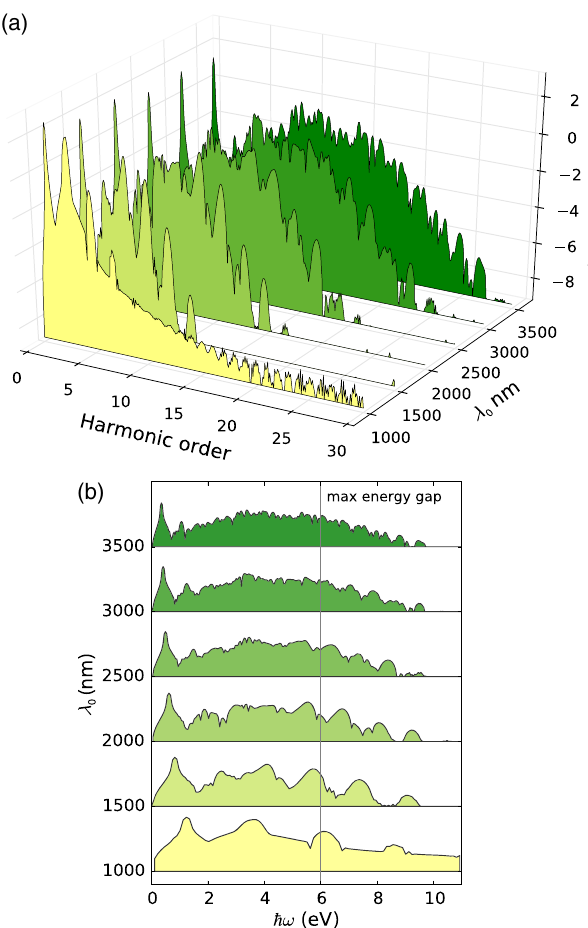
0 rad. The CEP ¼